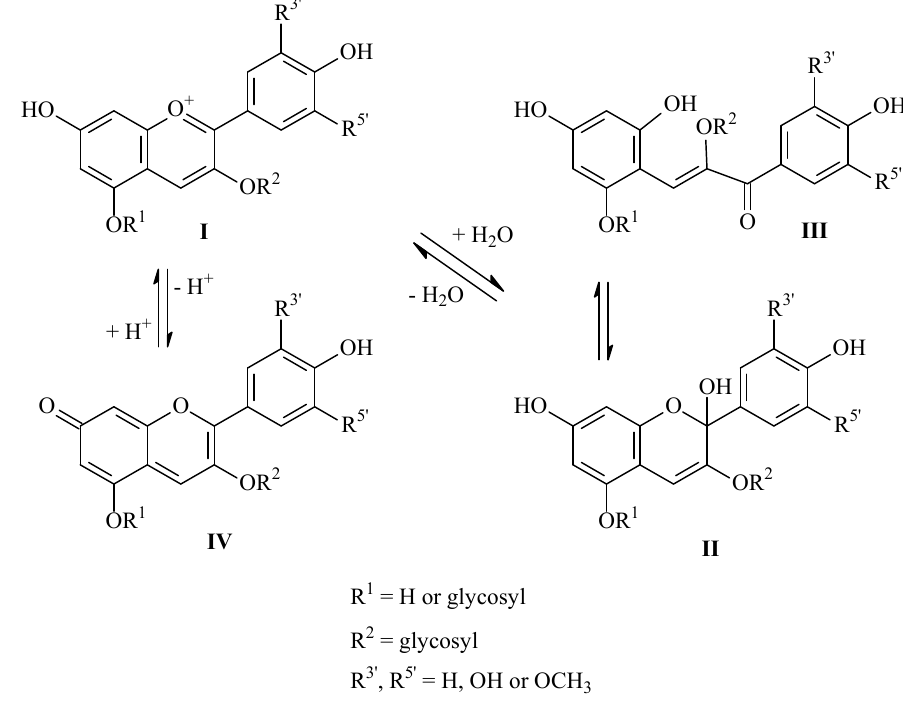
Scheme 1. Chemical structures of anthocyanins at different pH